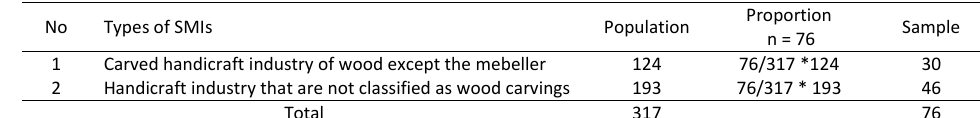
Table 3: Sample number determination Table 3. Sample number